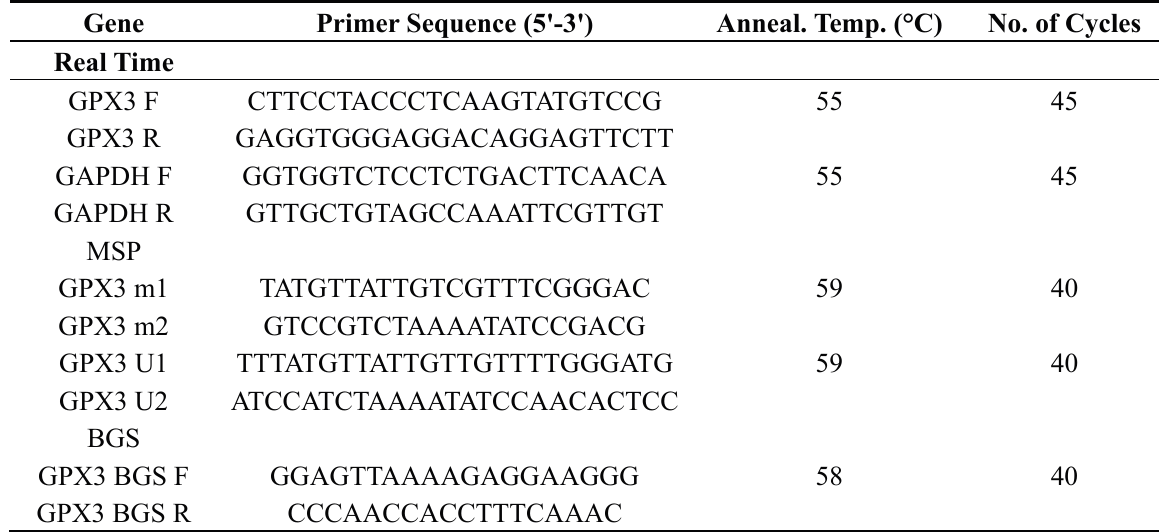
Table 2. Primer sequences used in this